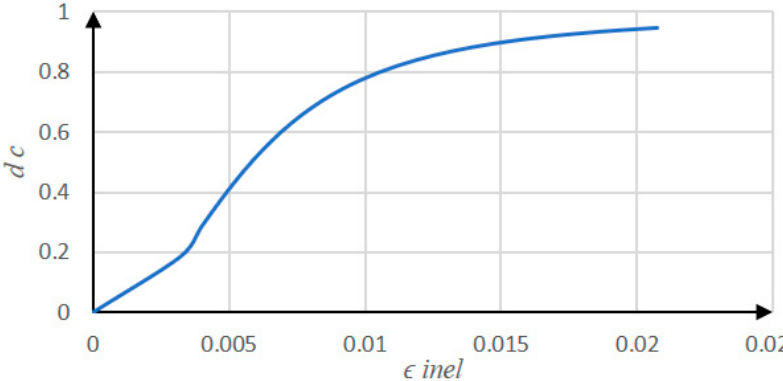
Figure 12. Stress-strain for tension stress in concrete.